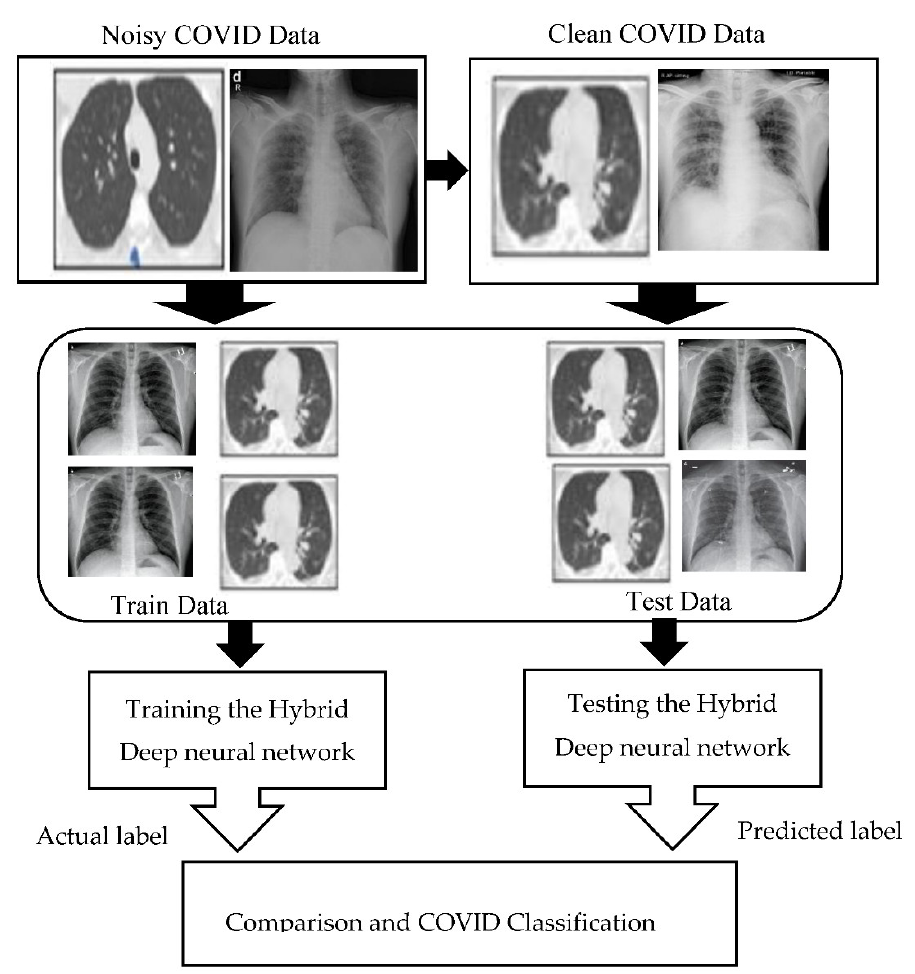
Figure 2. The block level representation of our proposed technique by using hybrid deep neural network (HDNNs) and chest X-ray.